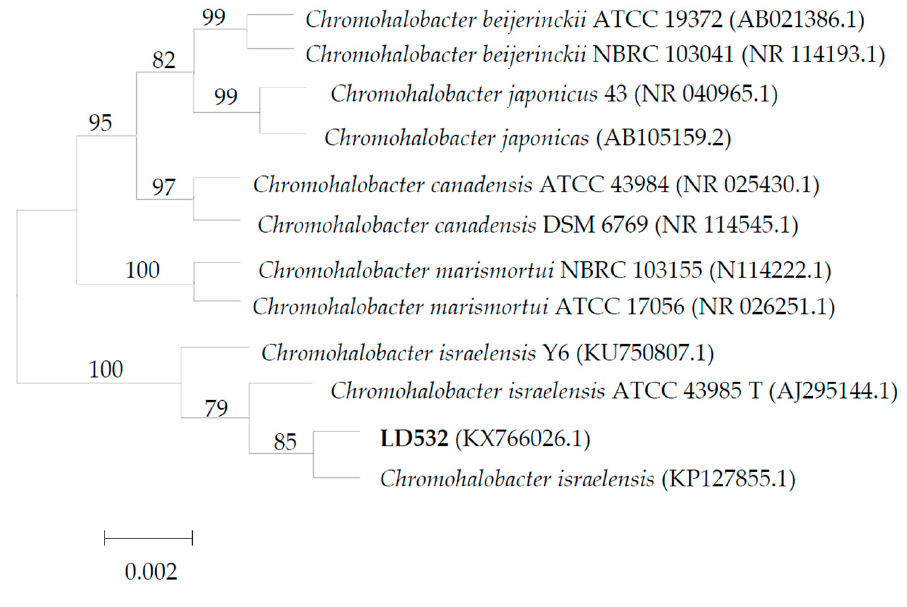
Figure 2. Phylogenetic tree of LD532 bacteria.